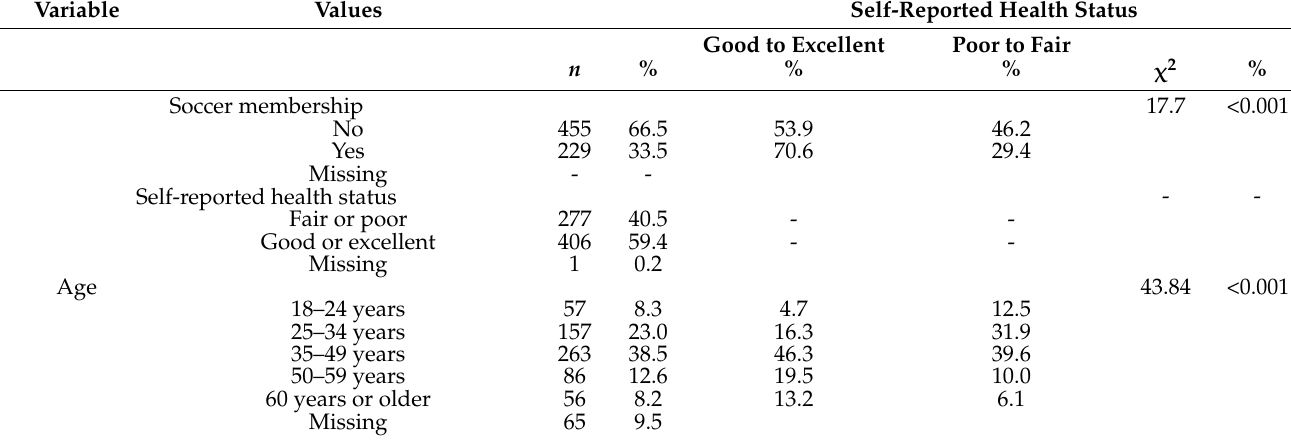
Table 1. Distribution of respondent attributes according to soccer participation and self-reported health status ( n = 684). Variable Values